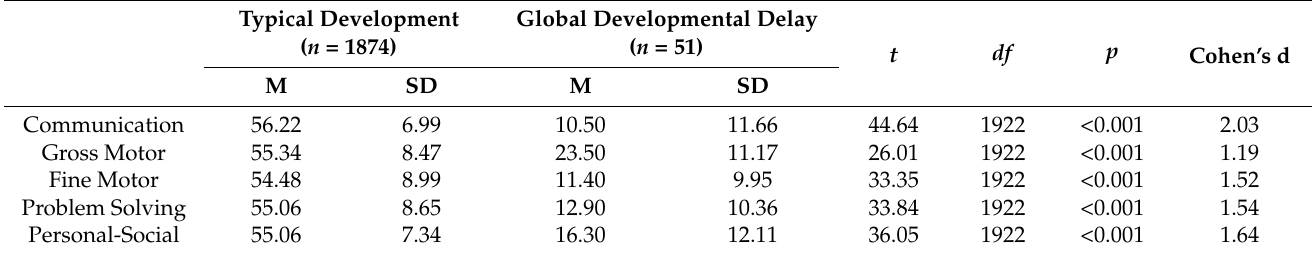
Table 9. Comparison group between children with Global Developmental Delay and Typical Devel- opment on ASQ-3.